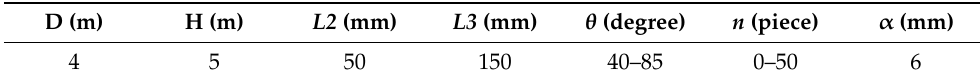
Table 3. Geometry parameters of the tower and